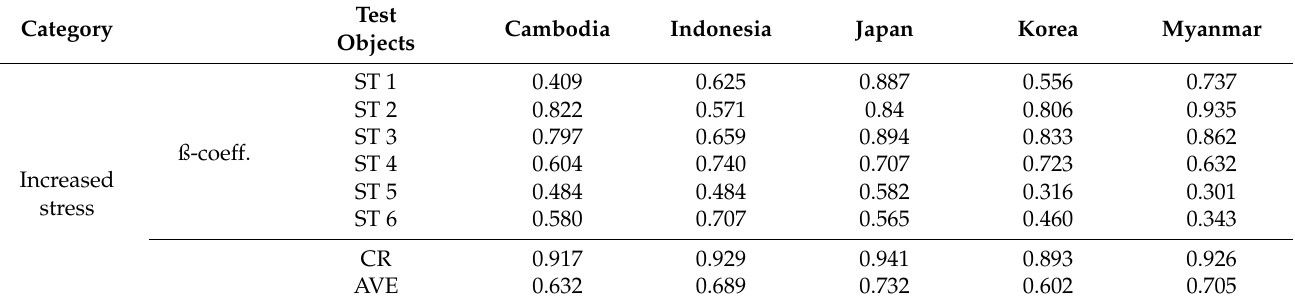
Table 5. Confirmatory factor